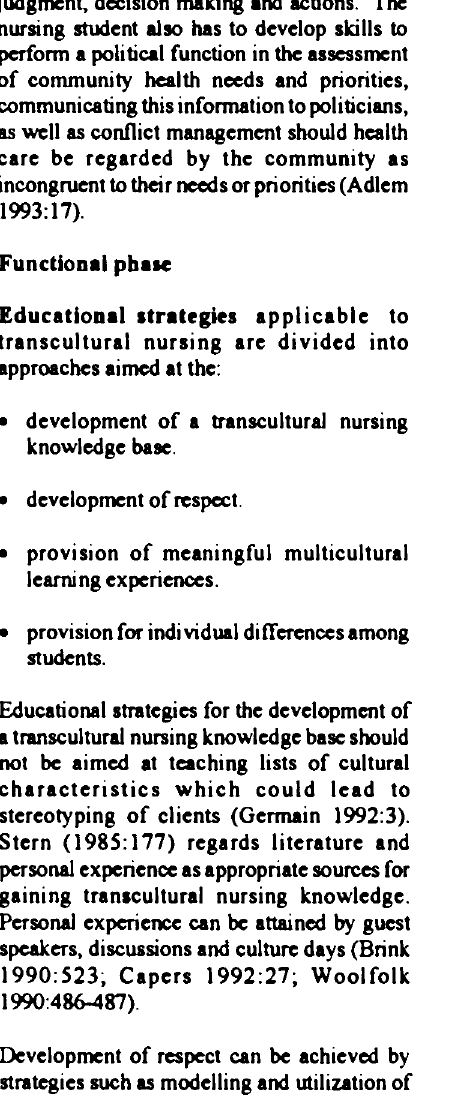
Table 3 Including transculturai nursing In the curriculum: Planning quide